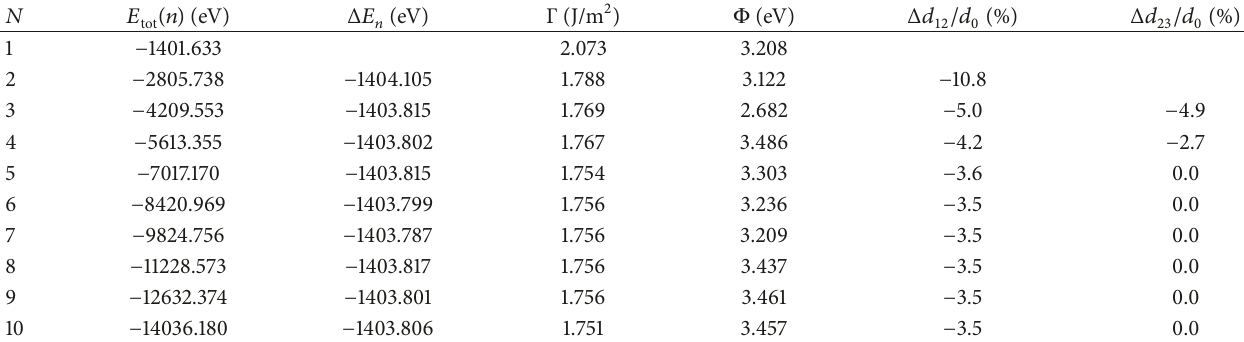
Table 3: Surface properties of U(001) a .